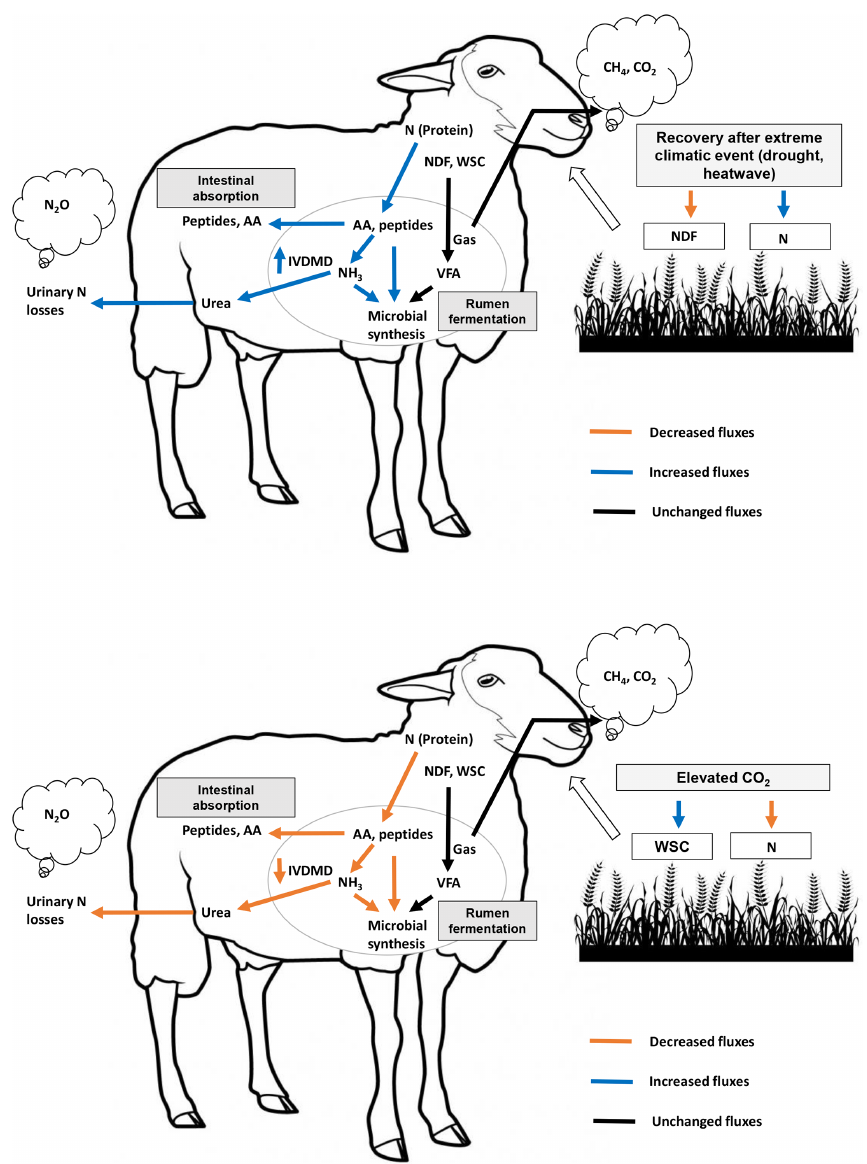
Figure 4. Schematic overview of treatment effects (recovery after an extreme climatic event, ECE, and elevated atmospheric CO 2 concen- tration) on forage quality, digestive use of macronutrients by the ruminant and atmospheric greenhouse gas emissions. WSCs: water-soluble carbohydrates; N: nitrogen; NDF: neutral detergent fiber (cell wall carbohydrates); AAs: amino acids; VFAs: volatile fatty acids; CH 4 : methane; CO 2 : carbon dioxide; NH 3 : ammonia; N 2 O: nitrous oxide; IVDMD: in vitro dry matter